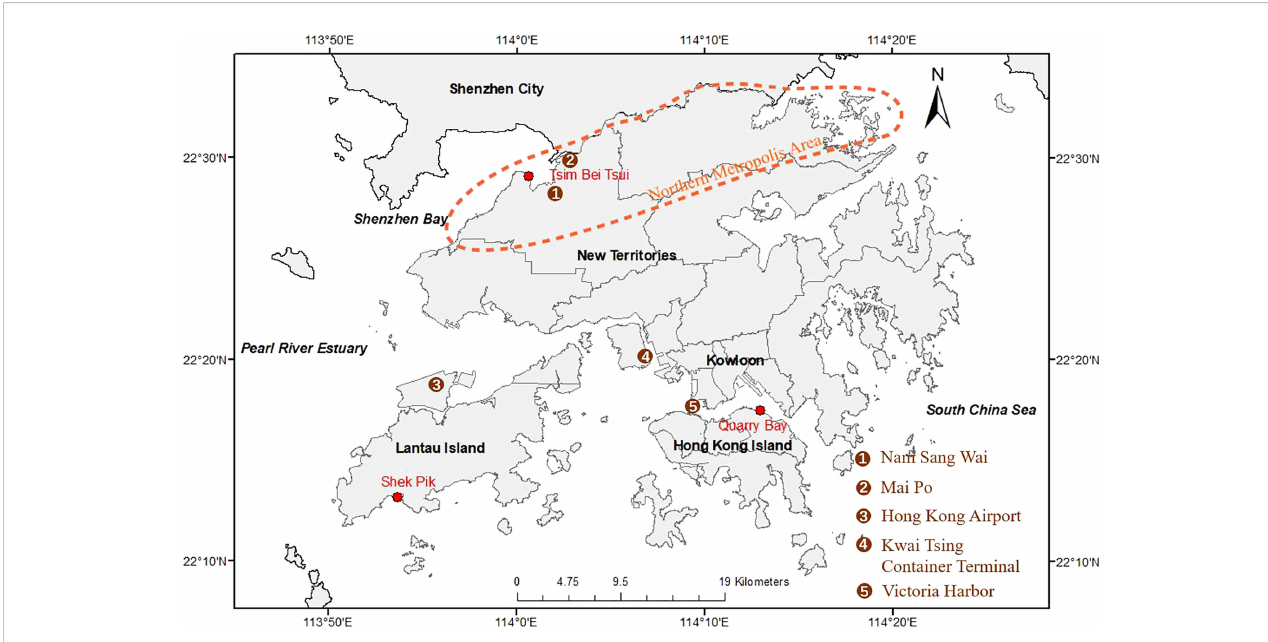
FIGURE 1 Location of the study area. Red points are the locations of three tide gauge